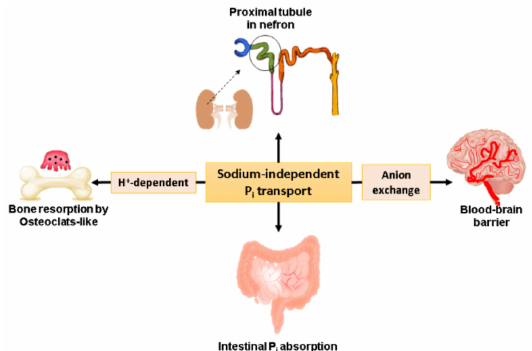
Figure 1. Schematic representation of the roles of sodium-independent Pi transport in Pi homeostasis. Na + -independent Pi transport facilitates the absorption of Pi in intestinal cells [9,19] and proximal tubule cells [10] and the reabsorption of Pi in bone by osteoclast-like cells derived from RAW264.7 cells (H + -dependent Pi transport) [11] and in capillaries of the blood–brain barrier (BBB) (anion exchange)